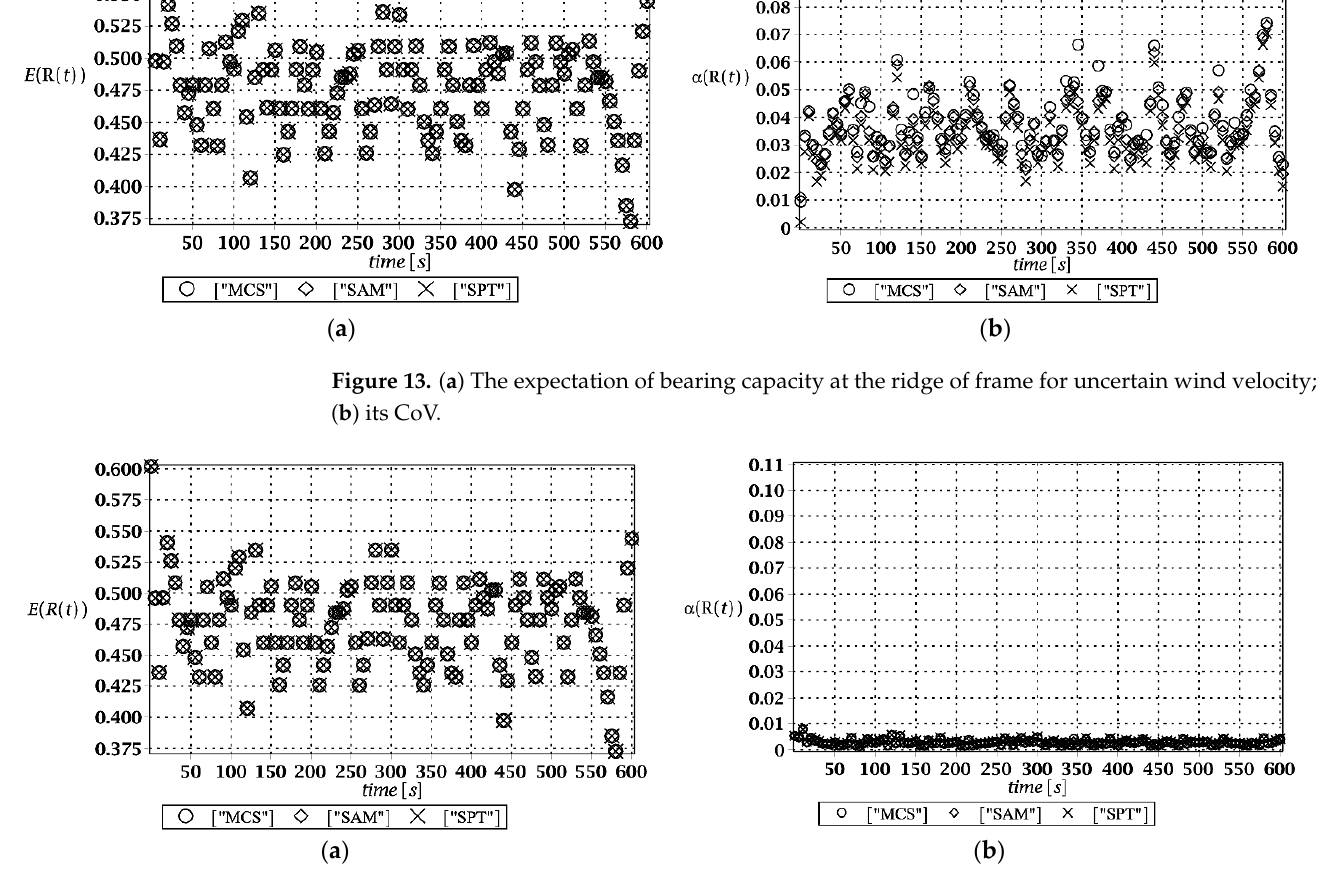
Figure 14. ( a ) The expectation of bearing capacity at the ridge of frame for uncertain Young modulus; ( b ) its CoV.